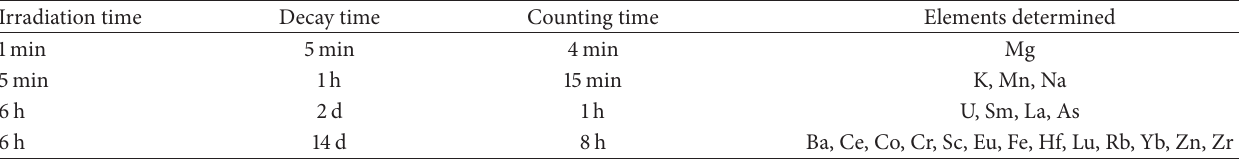
Table 1: Irradiation conditions of elements determined [19].